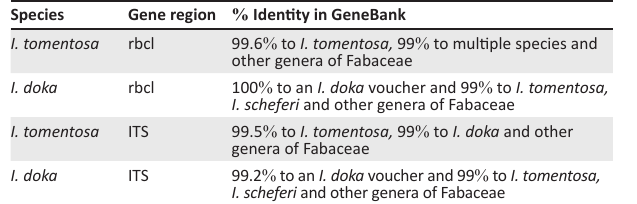
FIGURE 6: Phylogenetic tree of Isoberlinia tomentosa and Isoberlinia doka . TABLE 6: Percentage BLAST identity of Isoberlinia doka and Isoberlinia tomentosa with the GeneBank sequence data.